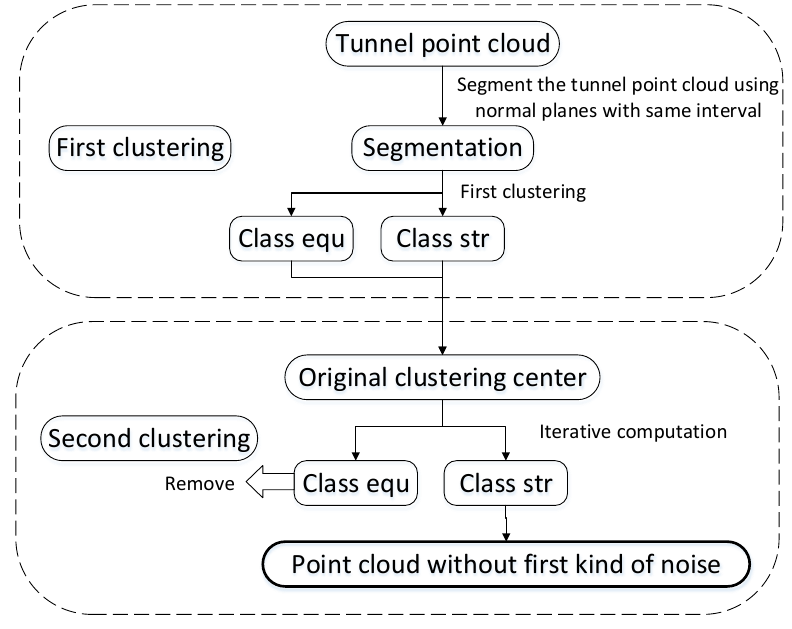
Figure 5. Flow chart of the proposed denoising algorithm using double clustering based on the distance and